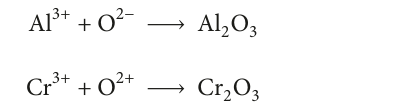
Figure 9: Wear rate of Inconel 617 alloy substrate and cladding at different